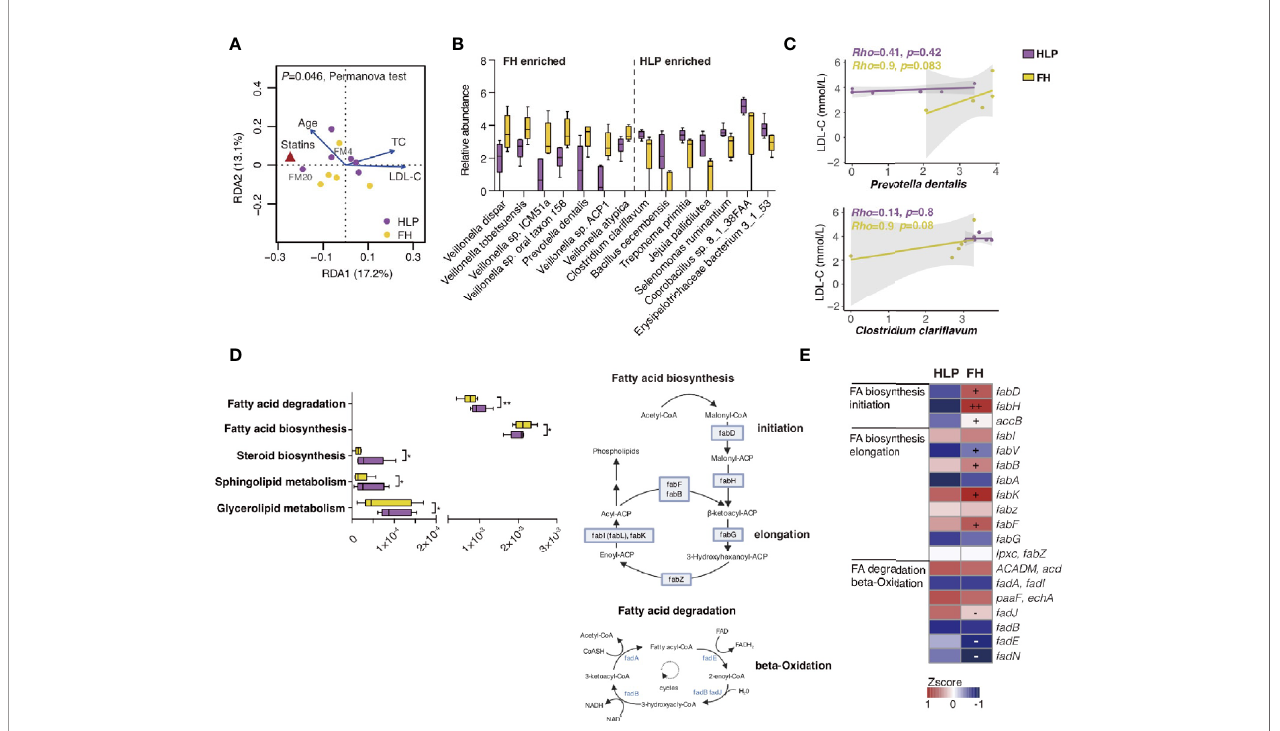
FIGURE 2 | Metagenomics pro fi le of this HeFH family. (A) Distance-based redundancy analysis (dbRDA) plot based on clinical parameters fi tted to the variation in gut microbiota. (B) Relative abundance of signi fi cantly differed species between FH and HLP individuals (P < 0.05, Wilcoxon rank sum test). Boxes represent the inter-quartile ranges, and lines inside the boxes denote medians. (C) Spearman correlations between bacterial relative abundance and LDL-C levels. (D) Alterations in gut microbial lipid functional modules. *P < 0.05; **P < 0.01. (E) KO genes signi fi cantly changed between FH and HLP individuals are shown in the heat map. Signi fi cant changes (elevation and depletion) are denoted as follows: +, elevation with P < 0.05; − , depletion with P <